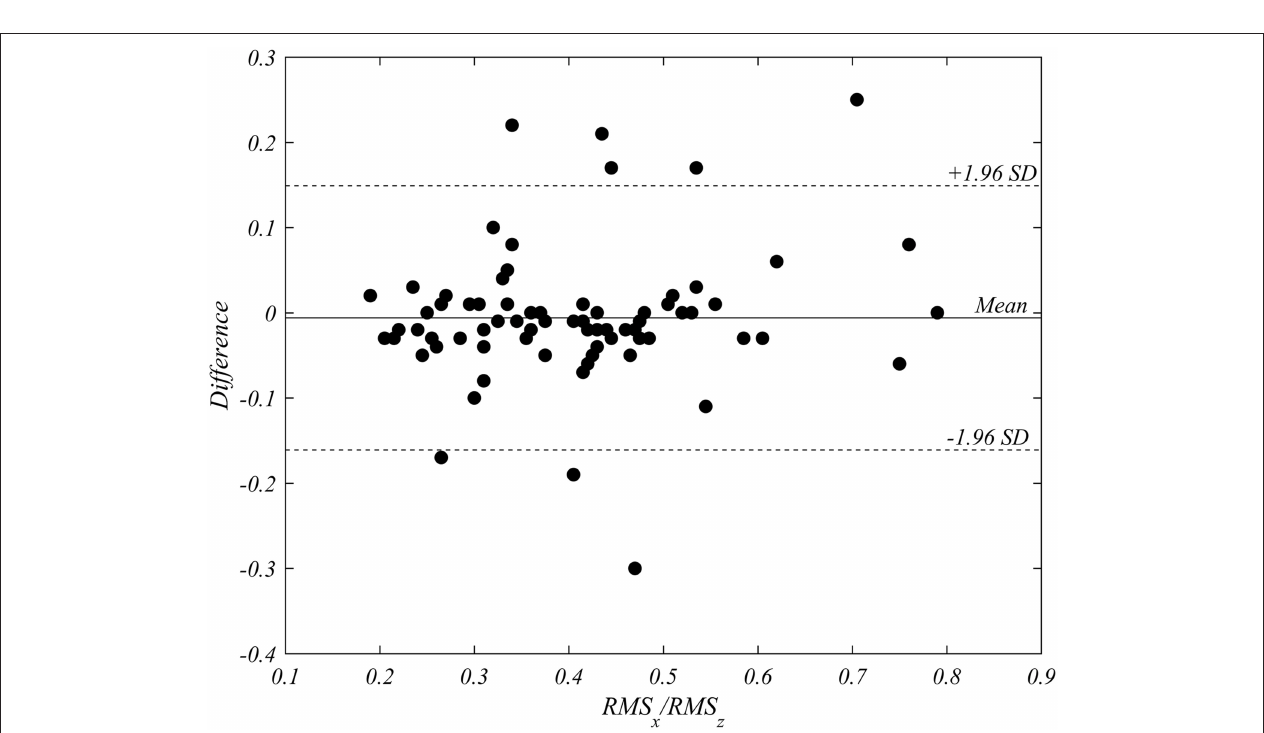
FIGURE 4 | Bland-Altman analysis of inter-operator variability in the triplane measurement of RMSx/RMSz. The analysis performed on all patients in both pre- and post-implant recordings (76 cases), shows the absence of a systematic